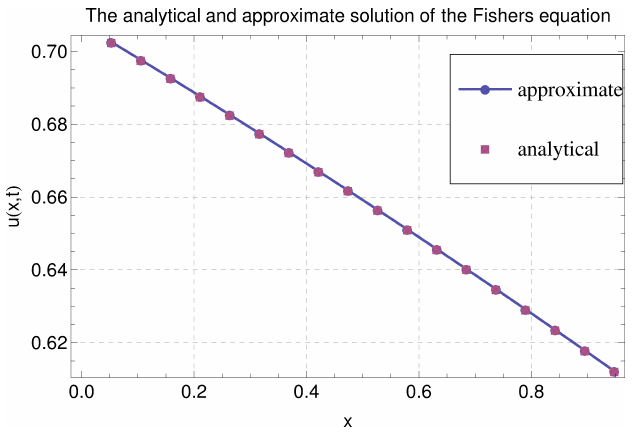
Fig. 1. Solution of the Fisher’s equation